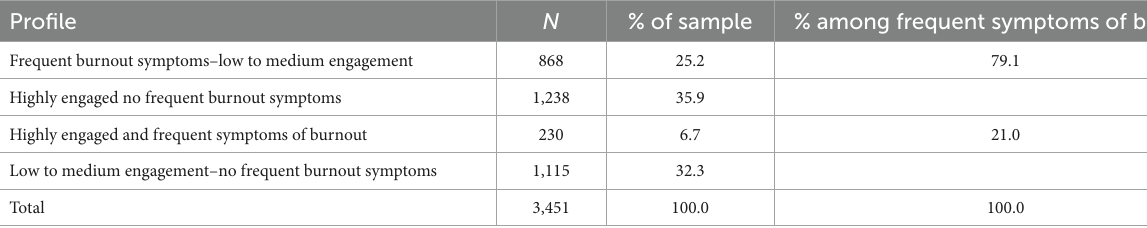
TABLE 3 Different profiles of burnout and study engagement.